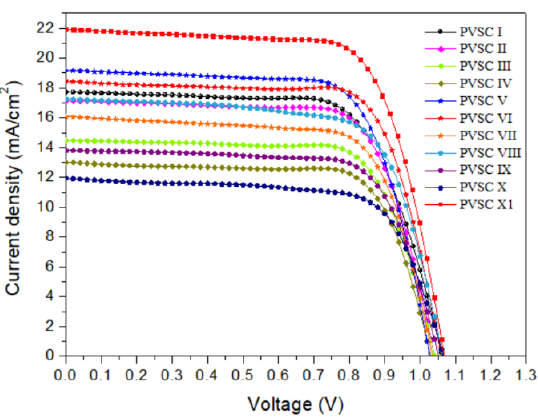
Figure 11. Current density–voltage characteristics of illuminated (AM 1.5G, 100 mW cm − 2 ) PVSCs.